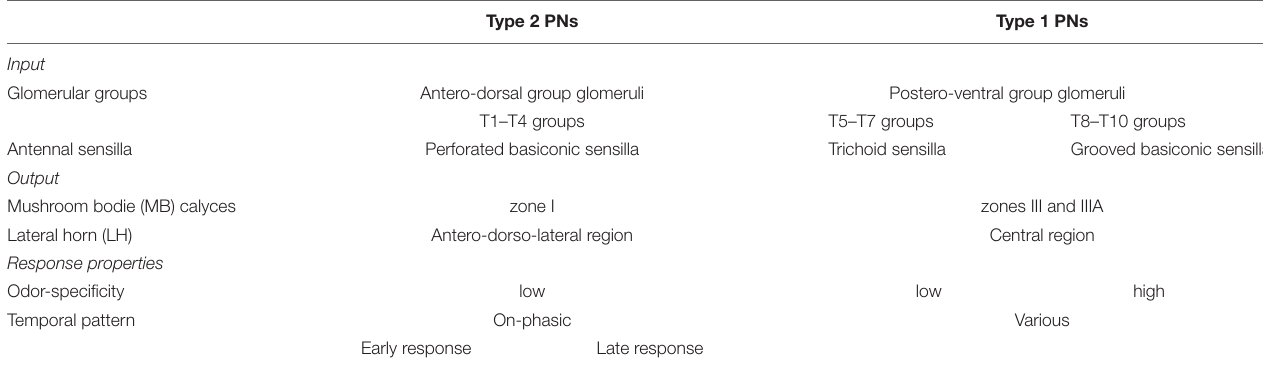
TABLE 1 | Anatomical and physiological differences between type1 and type2 projection neurons